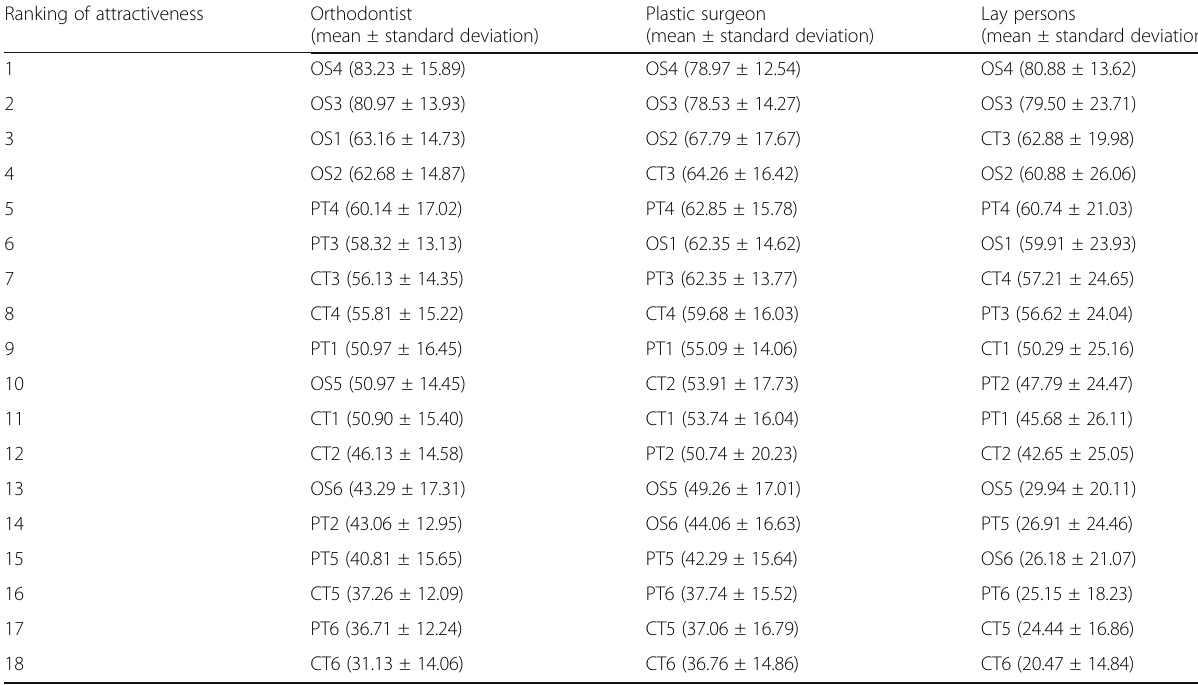
Table 1 Attractiveness ranking of photographs according to the groups Ranking of